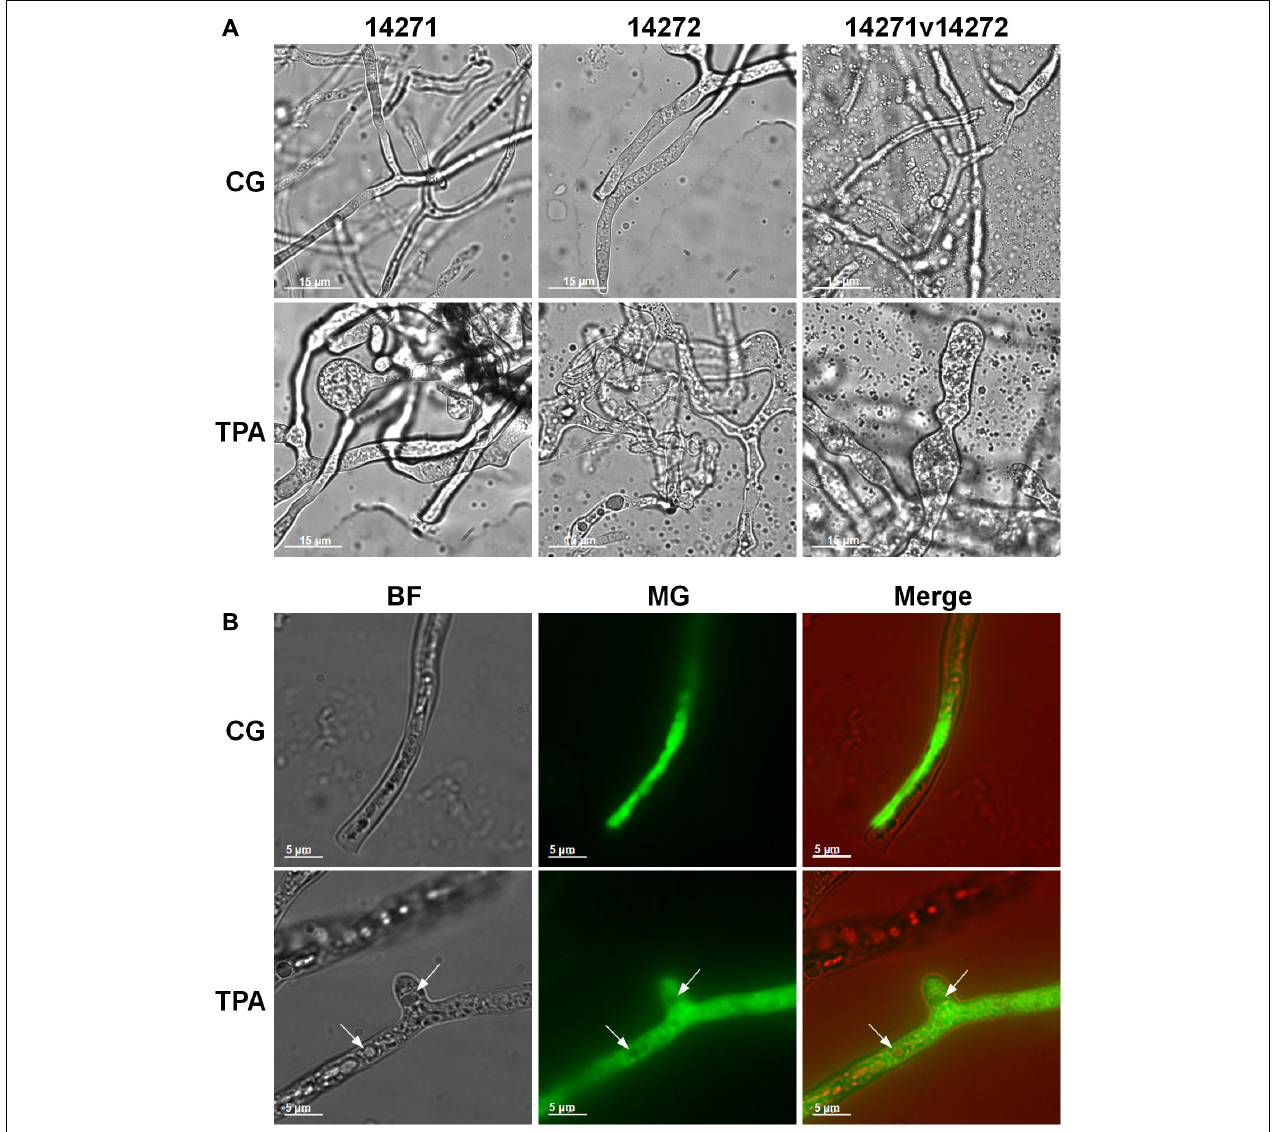
FIGURE 4 | Mycelial morphology of B. trispora after treatment with TPA. (A) Mycelium in fermentation. (B) Fluorescence images ( × 200) of B. trispora stained with Mito-tracker Green. BF, brightfield; MG, Mito-tracker Green; TPA, tripropylamine treated group; CG, control group. For the control group, B. trispora ATCC 14271(+) and 14272( − ) were fermented for 4 days. For the TPA-treated group, after the cultures had fermented for 2 days, TPA (1.8 g/L) was administered for 2